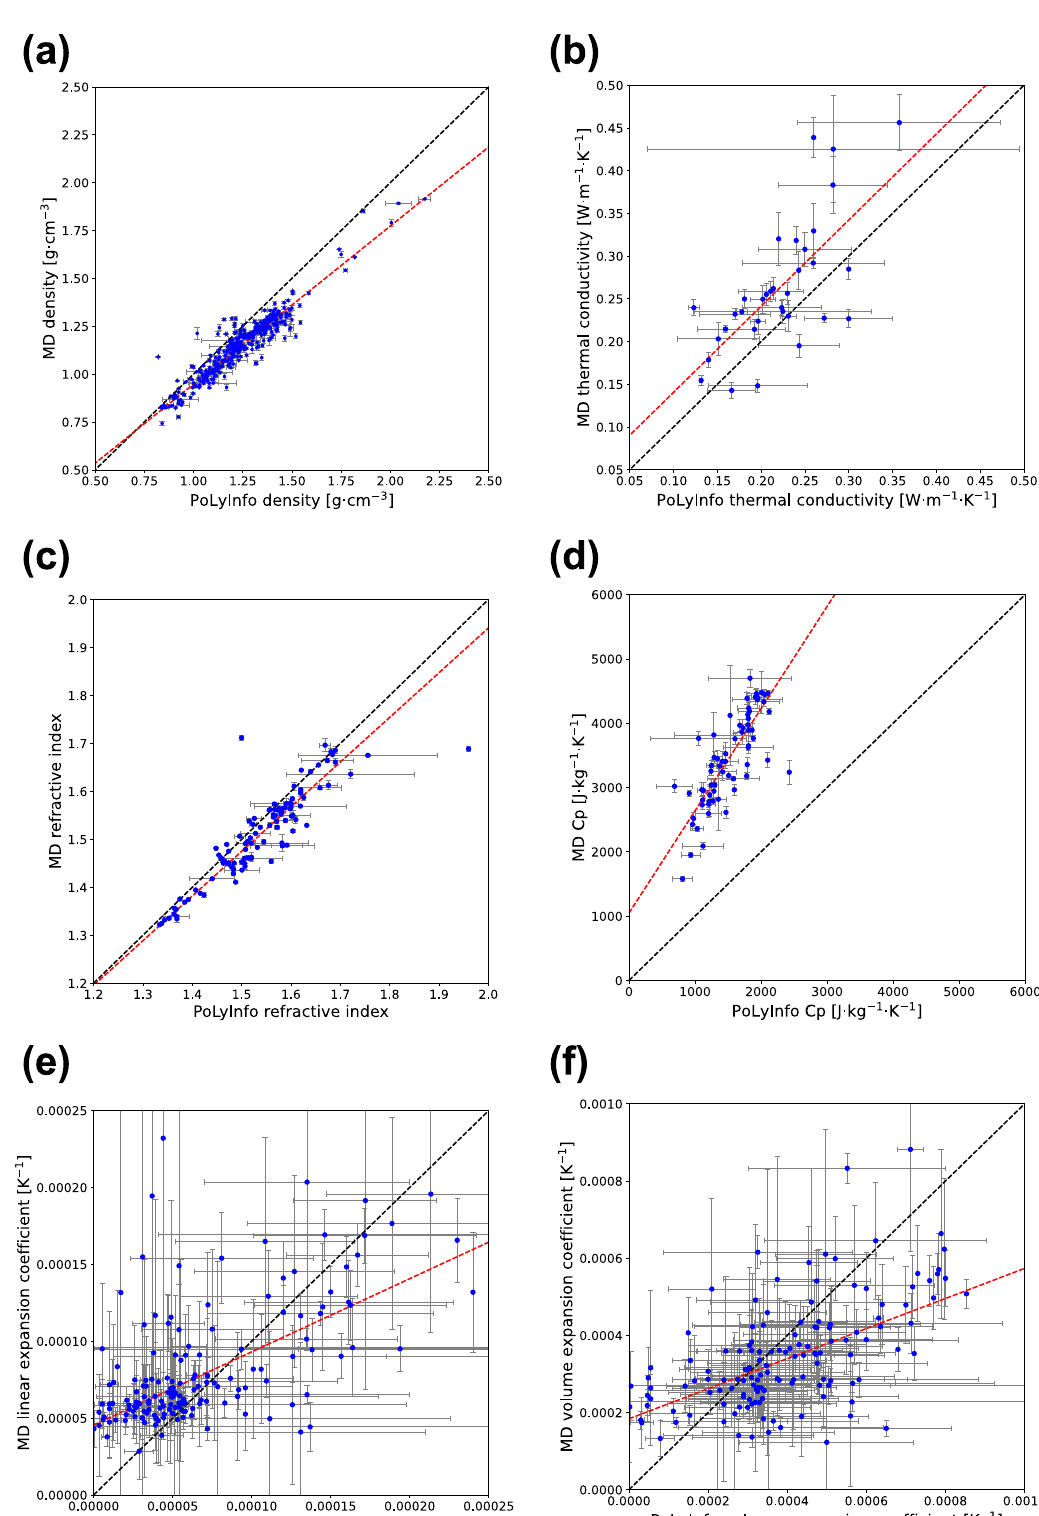
Fig. 3 Comparison between the MD-calculated properties of various amorphous polymers (vertical axis) and their experimental values in PoLyInfo (horizontal axis). The six panels show parity plots of ( a ) density ( N = 382), ( b ) thermal conductivity ( N = 34), ( c ) refractive index ( N = 107), ( d ) speci fi c heat capacity ( N = 66), ( e ) linear expansion coef fi cient ( N = 165), and ( f ) volume expansion coef fi cient ( N = 144). The error bar indicates the standard deviation of the calculated or measured properties within the same polymer. The dashed black line indicates the y = x line. The red line is the regression line fi tted to the calculated and experimental